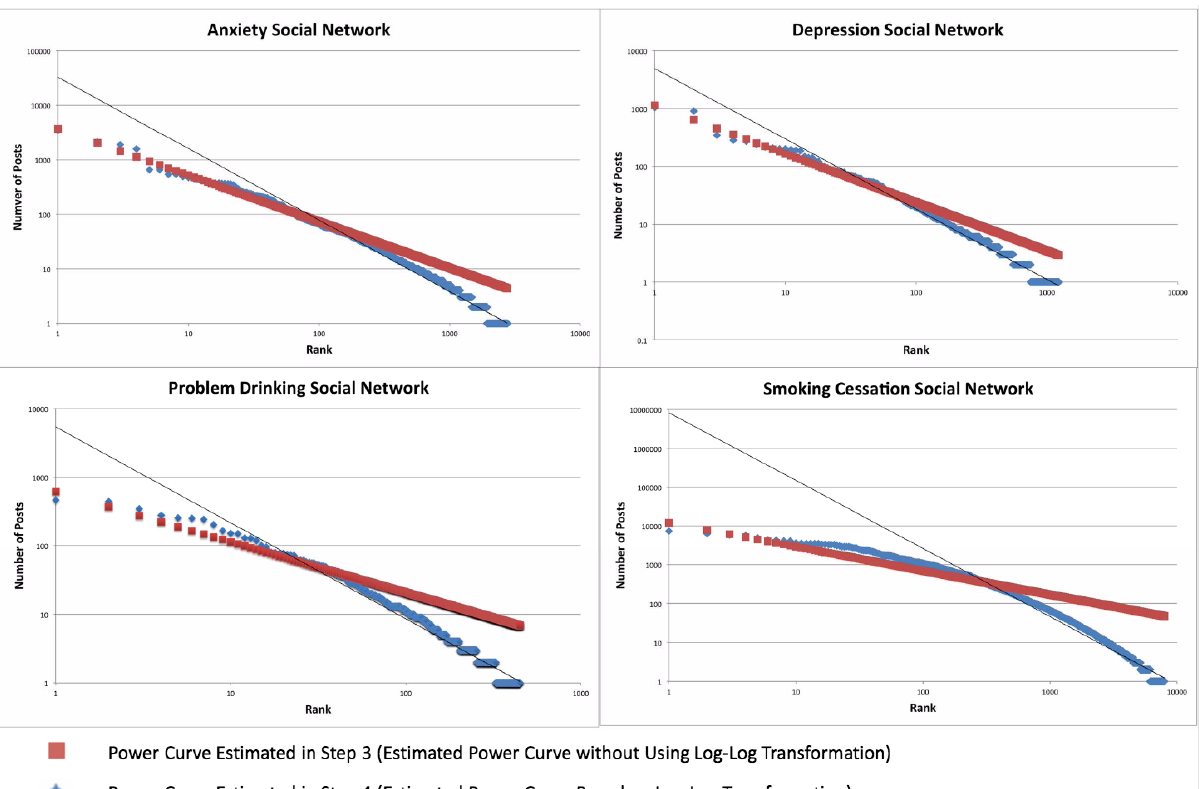
Figure 6. DHSN actor ranking and power curve ranking with trendline and R2